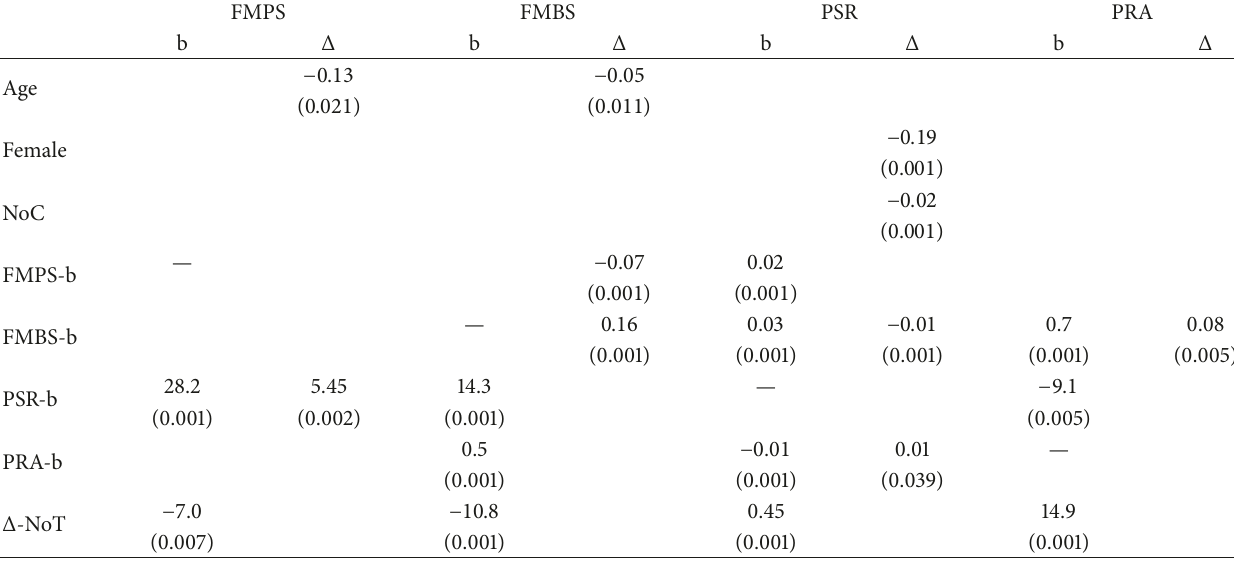
Estimated coefficients and 𝑝 values (in brackets) for the 4 seemingly unrelated regressions. Only variables abutting almost one significant correlation are reported. FMPS: full-mouth plaque score; FMBS: full-mouth bleeding score; PSR: periodontal screening and recording; PRA: periodontal risk assessment; NoC: number of cigarettes (per day); Δ -NoT: number of hopeless teeth extracted during cause-related therapy. b: baseline; Δ : Δ -check (maximum gap between check-I, check-II, and